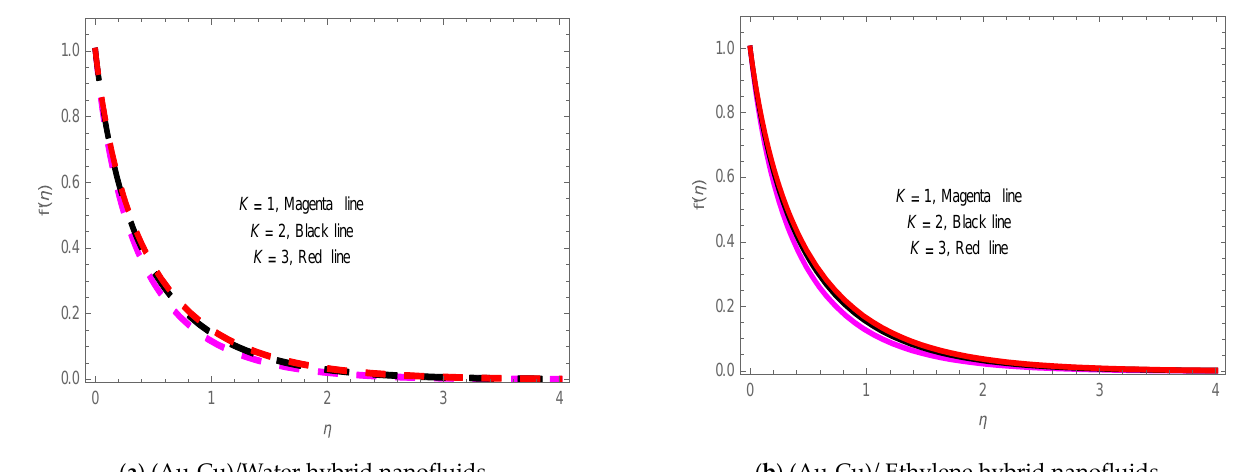
Figure 5. 𝑓 ′ (𝜂) for dissimilar values of m .